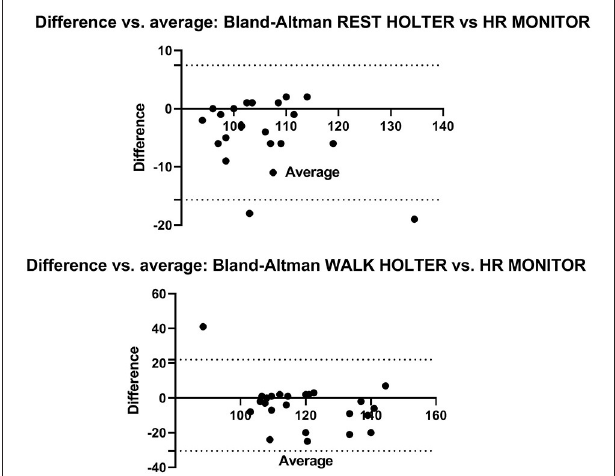
FIGURE 3 | The Bland-Altman plots show the agreement between the HOLTER and HR MONITOR monitors during HR measurement at REST (top) and WALK (bottom). The X axis is the average of the HOLTER and HR MONITOR, and the Y axis shows the mean difference between the methods. The dotted lines represent the upper and lower 95% limits of